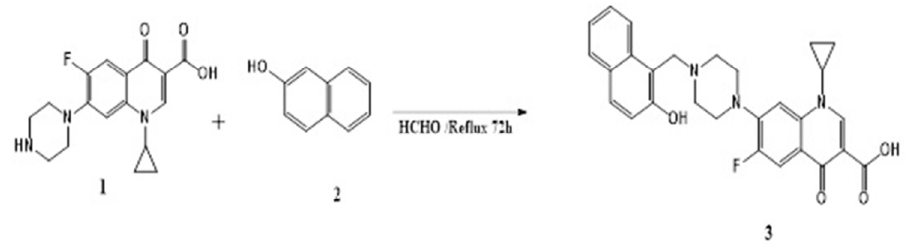
Figure 8. Synthesis of novel CMB